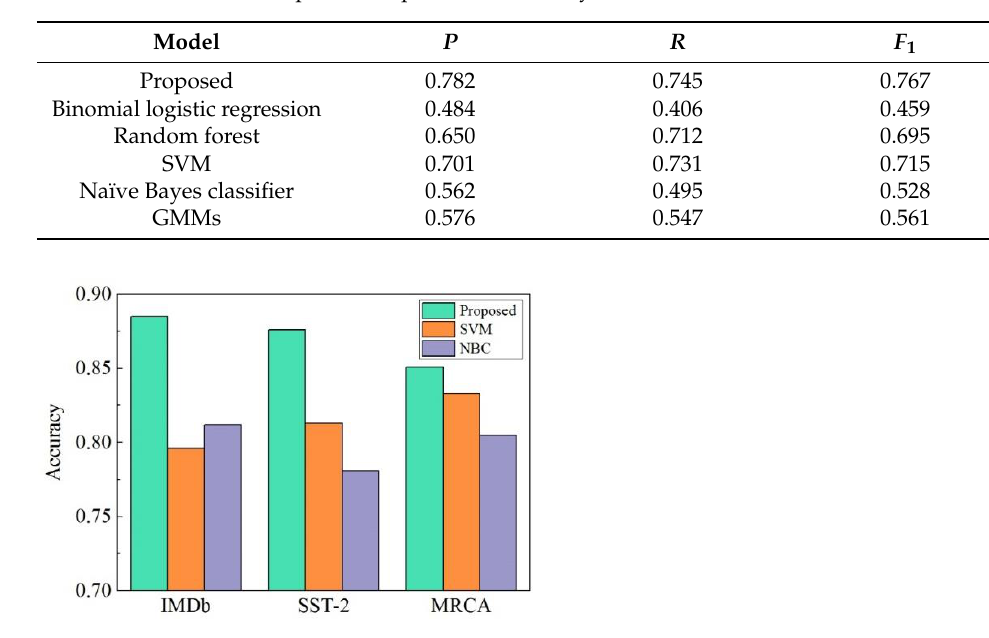
Figure 7. Model performance on open datasets.